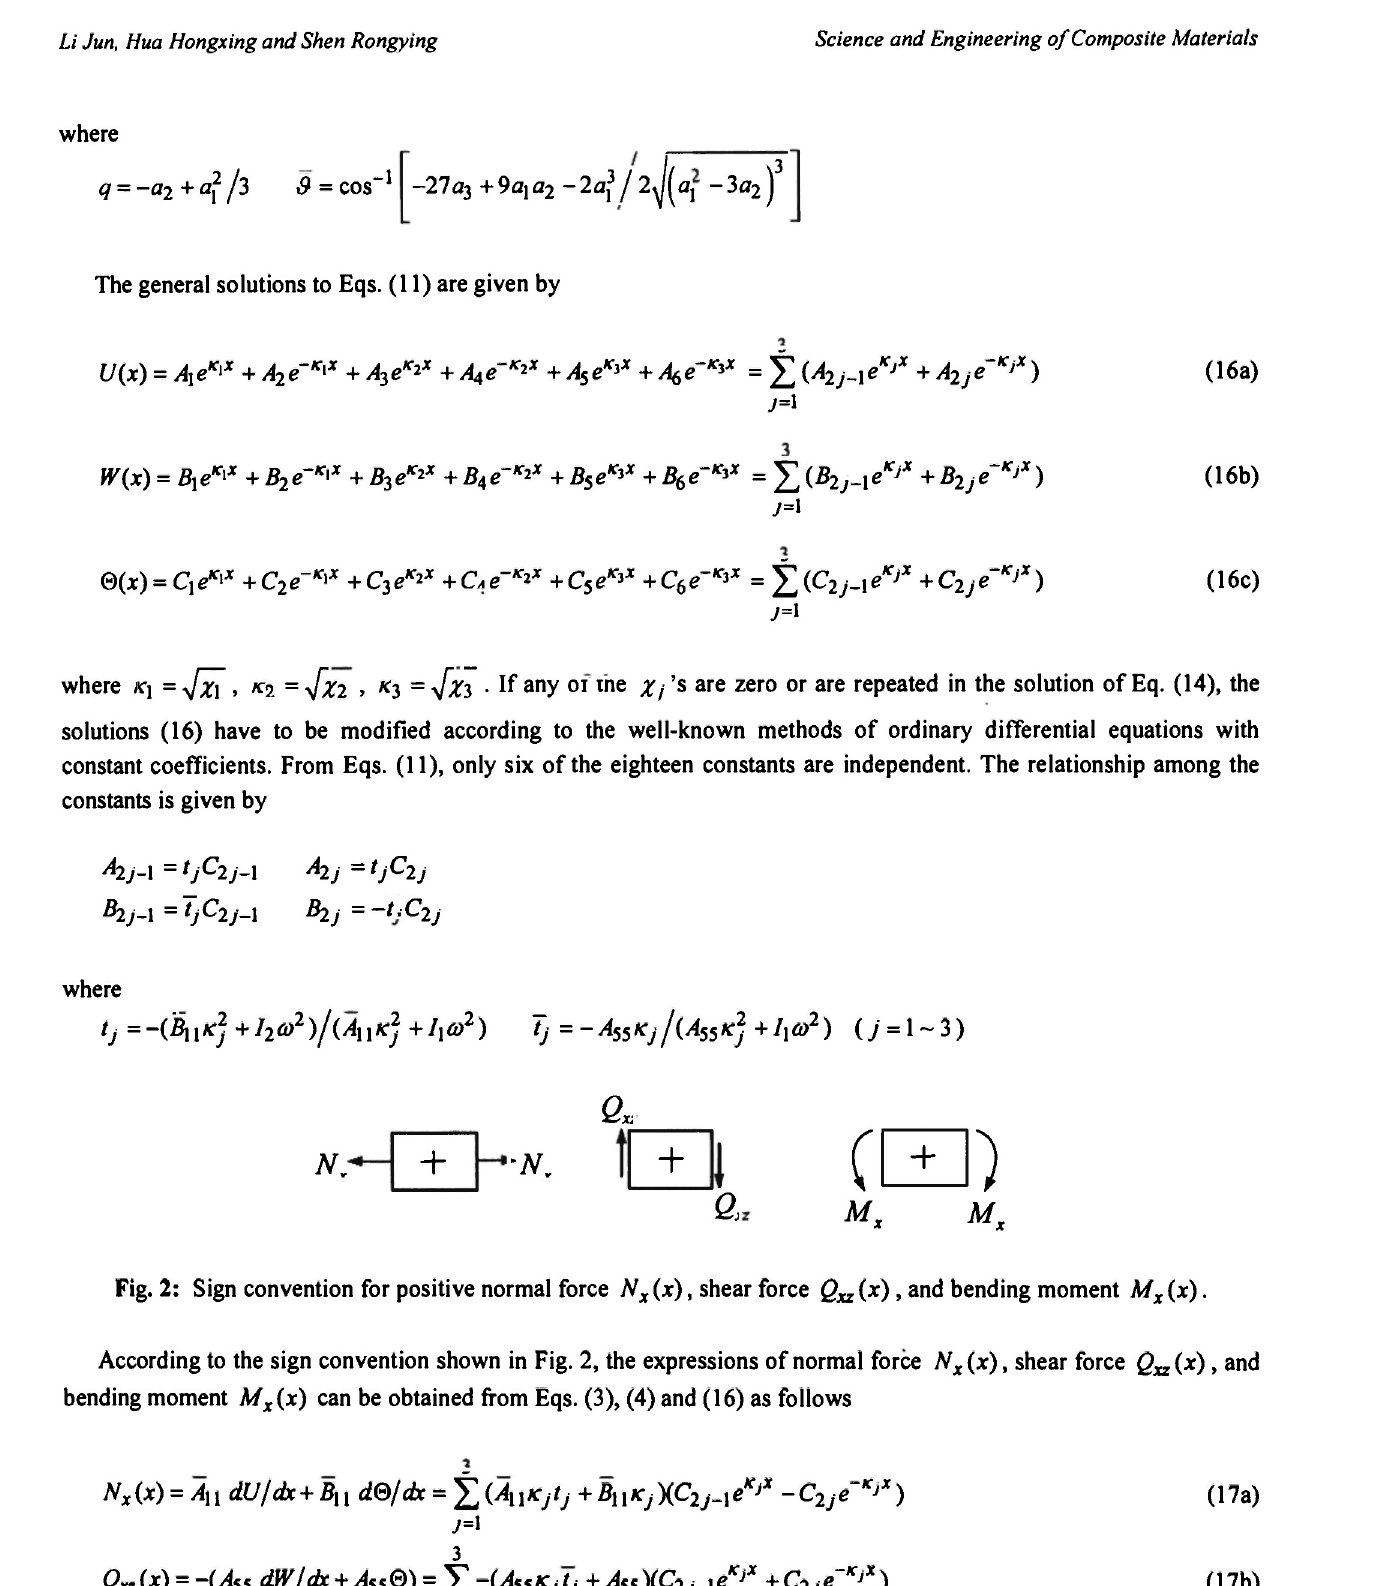
Fig. 2: Sign convention for positive normal force N x (χ), shear force Q^ (χ) , and bending moment M x (x). According to the sign convention shown in Fig. 2, the expressions of normal force N x (χ), shear force Q^ (χ), and bending moment M x